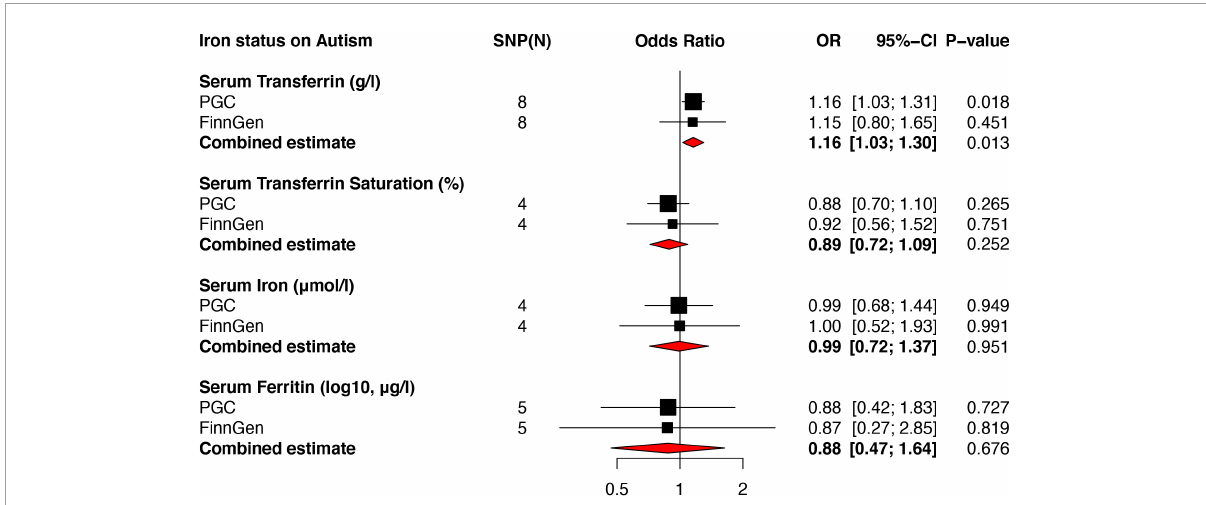
FIGURE2 Forest plots of MR analyses showing the causal effects of iron status on autism using the IVW method. Two independent autism genome-wide association studies (GWAS) datasets from PGC and FinnGen Consortium were used to evaluate the causal effect. The combined estimates were presented as red diamonds. PGC, psychiatric genomics consortium; IVW, inverse-variance weighted; MR, Mendelian